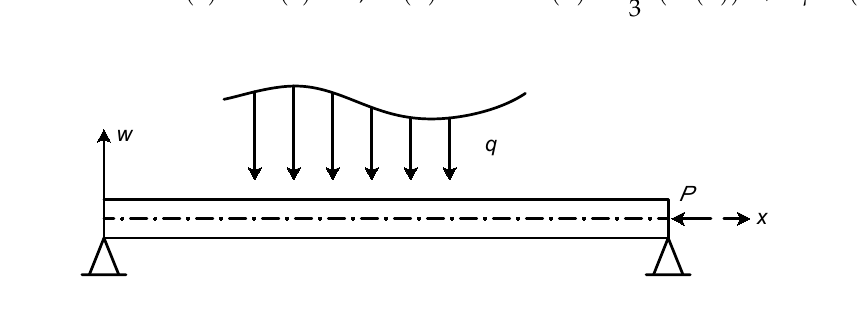
Figure 1. Simply supported beam